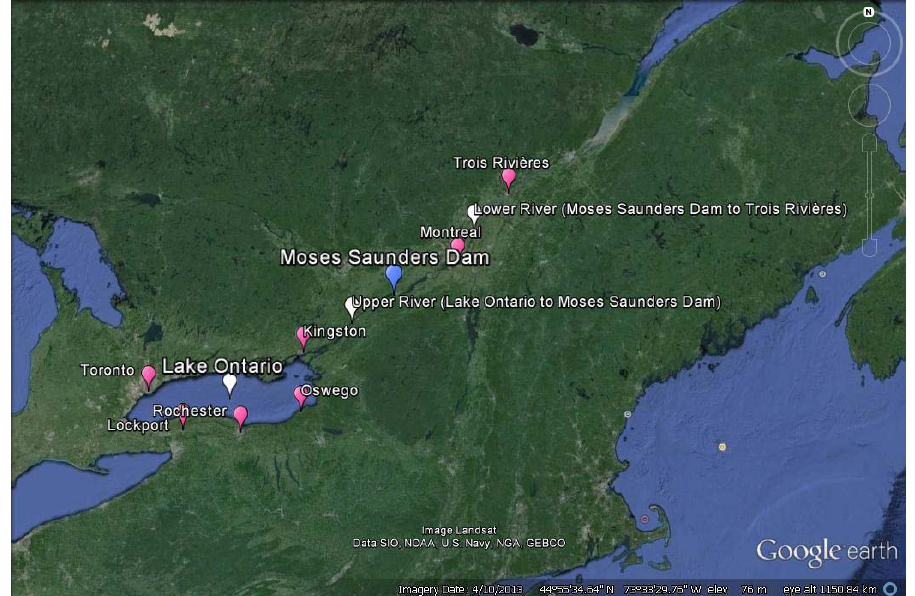
Figure 1. Map of Lake Ontario and the St. Lawrence River.